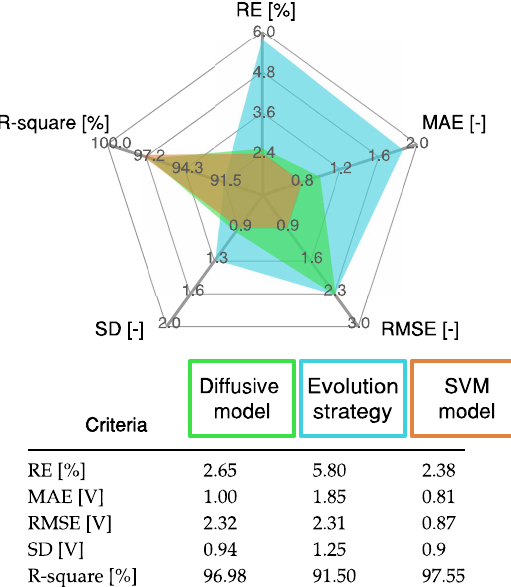
Figure 10. Statistical results of proposed SVM approach, diffusive global model, and ES approach for the profile shown in Figure 9.